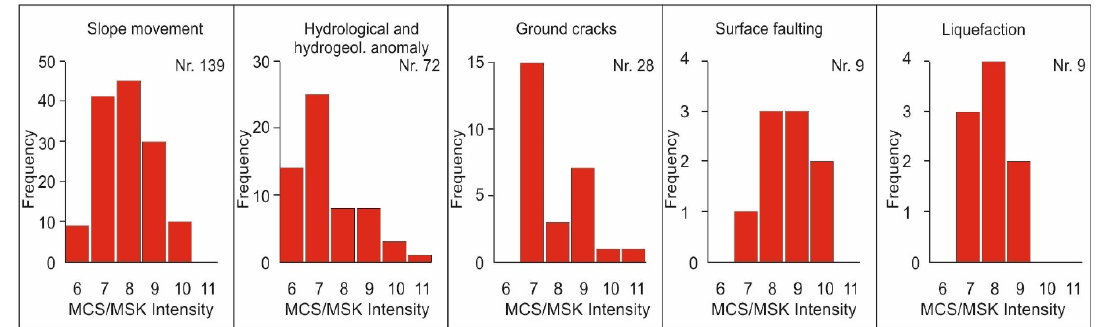
Figure 2. Histograms of the frequency distribution of the five EEEs for each class of MCS / MSK intensity. Primary e ff ects (i.e., surface faulting) were documented at only nine localities, 89% of which had an intensity value of I ≥ VIII. This higher threshold was expected because on-fault e ff ects occur by definition along the main fault or on distributed faults, which are usually located close of the main